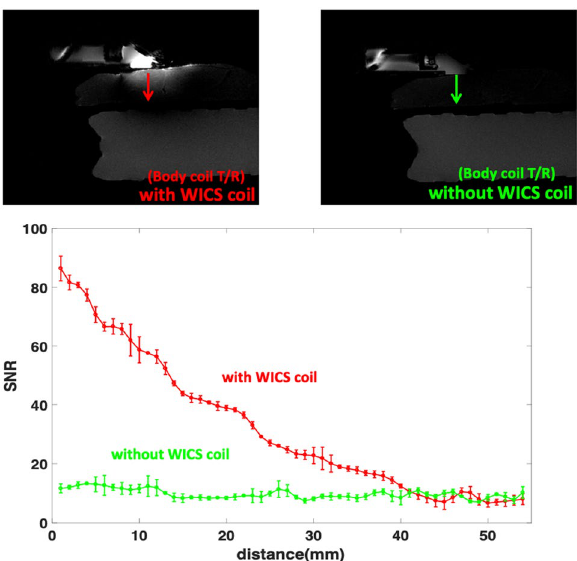
Figure 6. Top: The representative SNR maps with and without WICS coil in the ex vivo pork experiment. Bottom: Comparison of SNR through pork (arrow) derived from the top